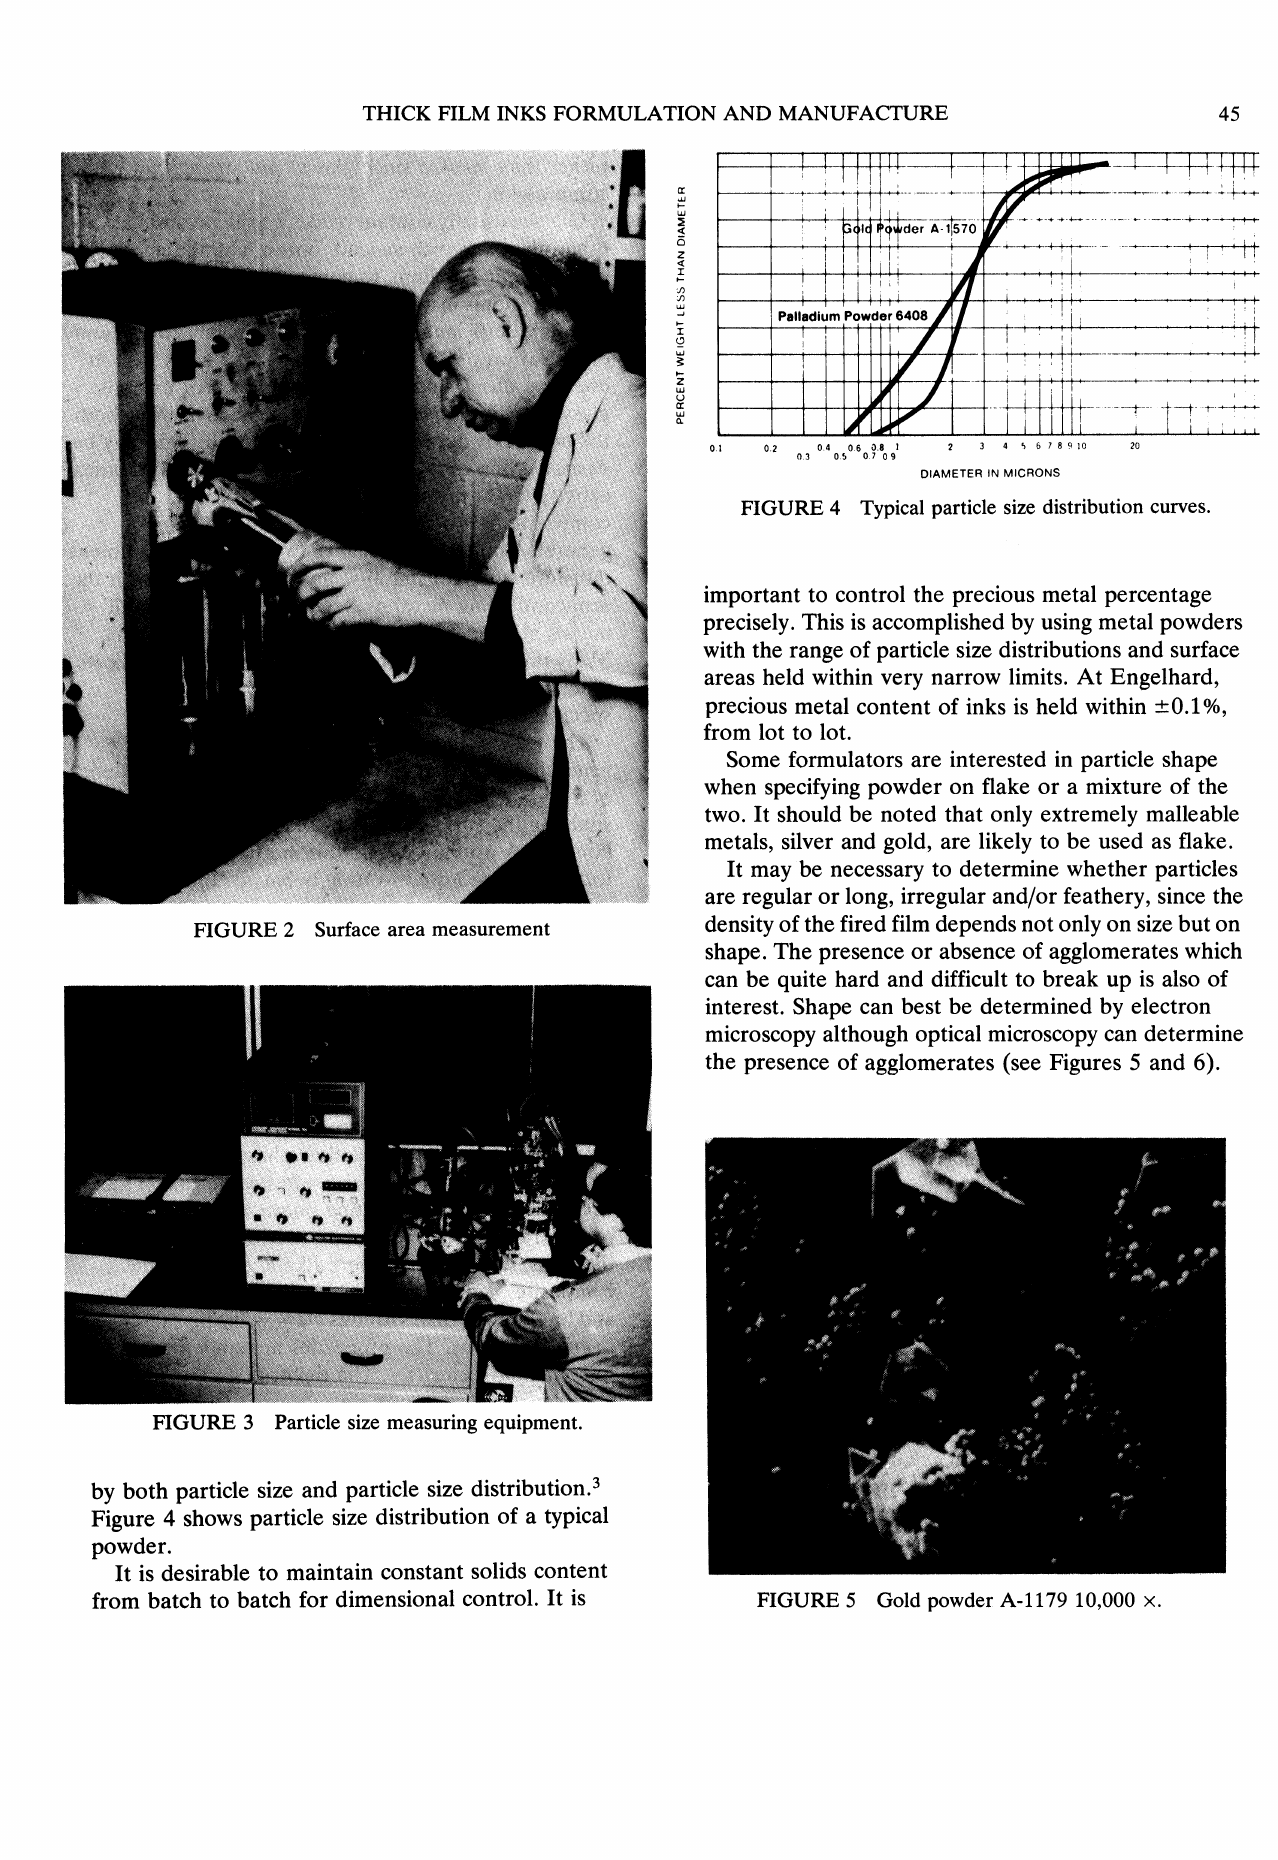
FIGURE 4 Typical particle size distribution curves.